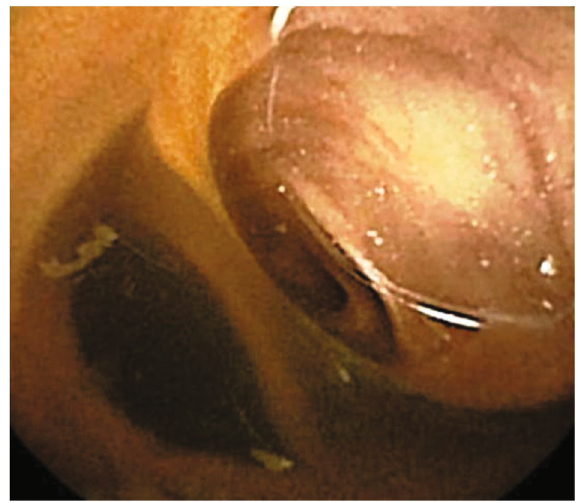
Figure 5: Capsule endoscopy showing two intestinal lumens in the distal